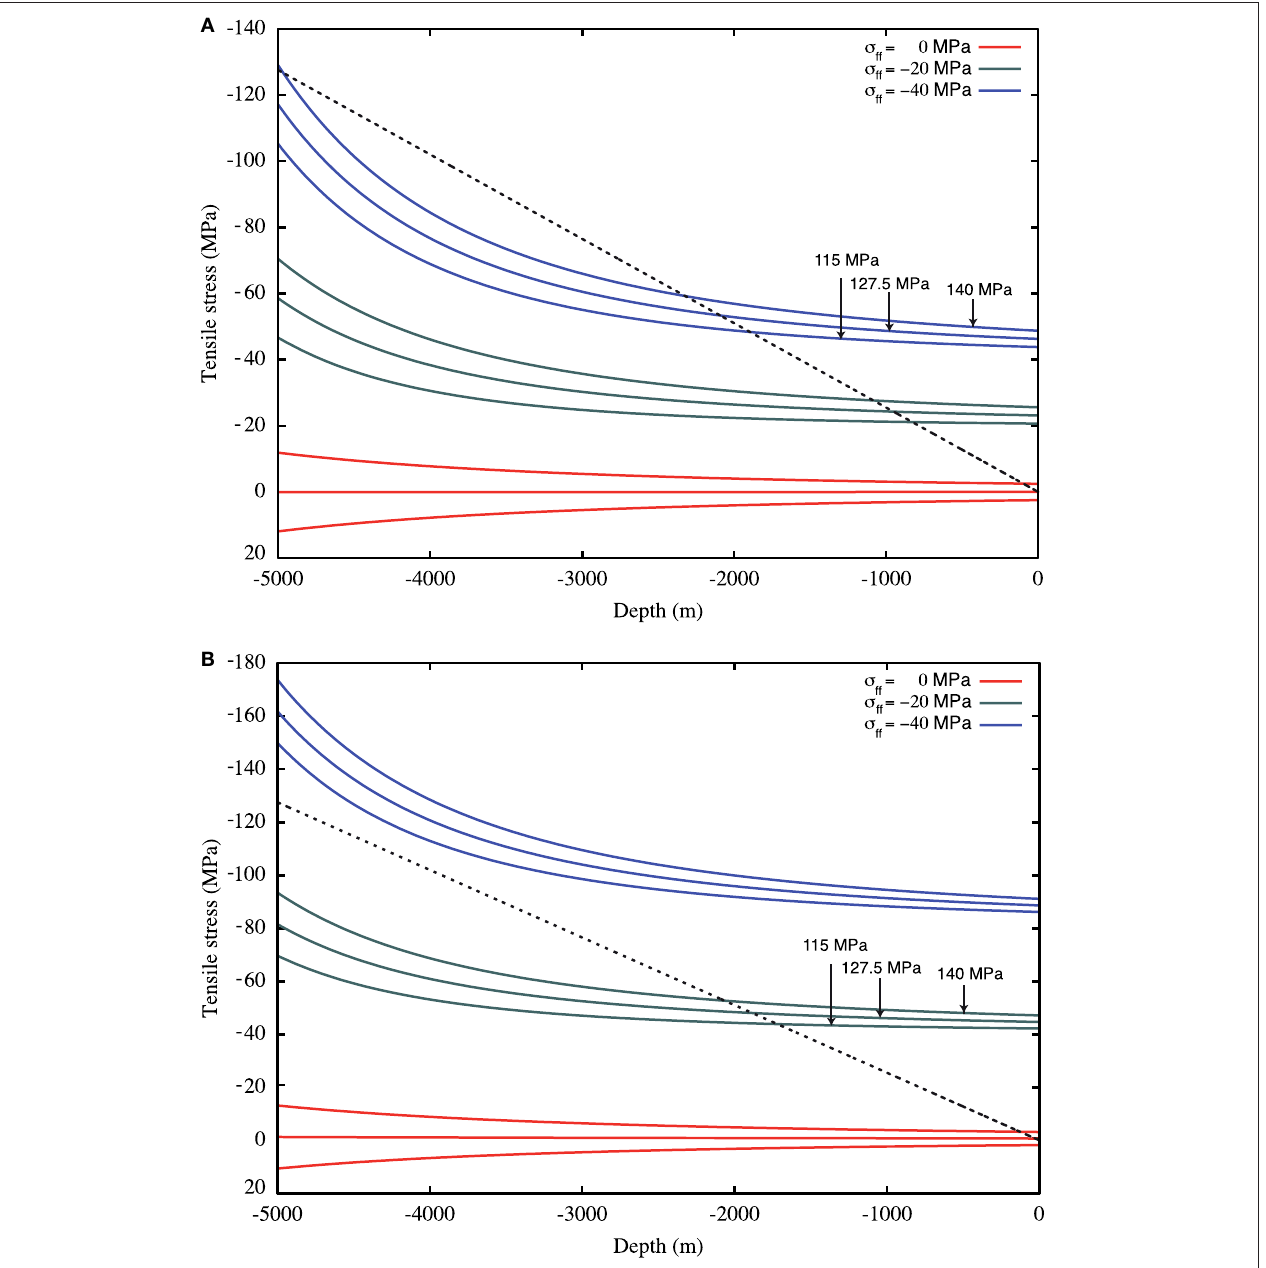
FIGURE 2 | Dyke tensile stress σ t profile along the vertical axis of the shallower dyke conduit obtained using the analytical solution presented by Gao (1996) for a pressurized magma chamber at 5 km depth (at lithostatic pressure and ± 12.5MPa, as indicated) under the effect of different far-field extensional stresses (from 0 to − 40MPa, as indicated in the figures), for an unpressurized magma reservoir (A) and a pressurized ( + 10MPa) reservoir at 10 km depth (B). Dashed line represents the lithostatic pressure. Note that the critical extensional stress that will produce a tensile stress at the dyke base able to counterbalance the lithostatic pressure is different in the two cases: in (A) for σ ff of − 40MPa or stronger the dyke remains open, whereas in (B) , due to the presence of a pressurized magma reservoir, this critical stress is decreased at 20–30MPa (for more realistic geometries these effects will be much larger, see Section Discussion and Open